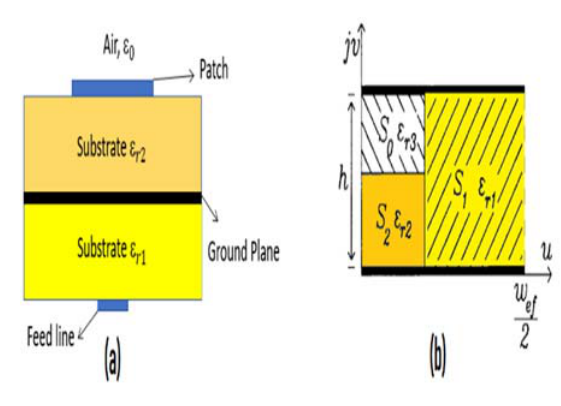
Fig 2. (a) Section of the under-review microstrip antenna structure, (b) Approximately how dielectric materials are distributed between parallel plates, as shown in [9] and